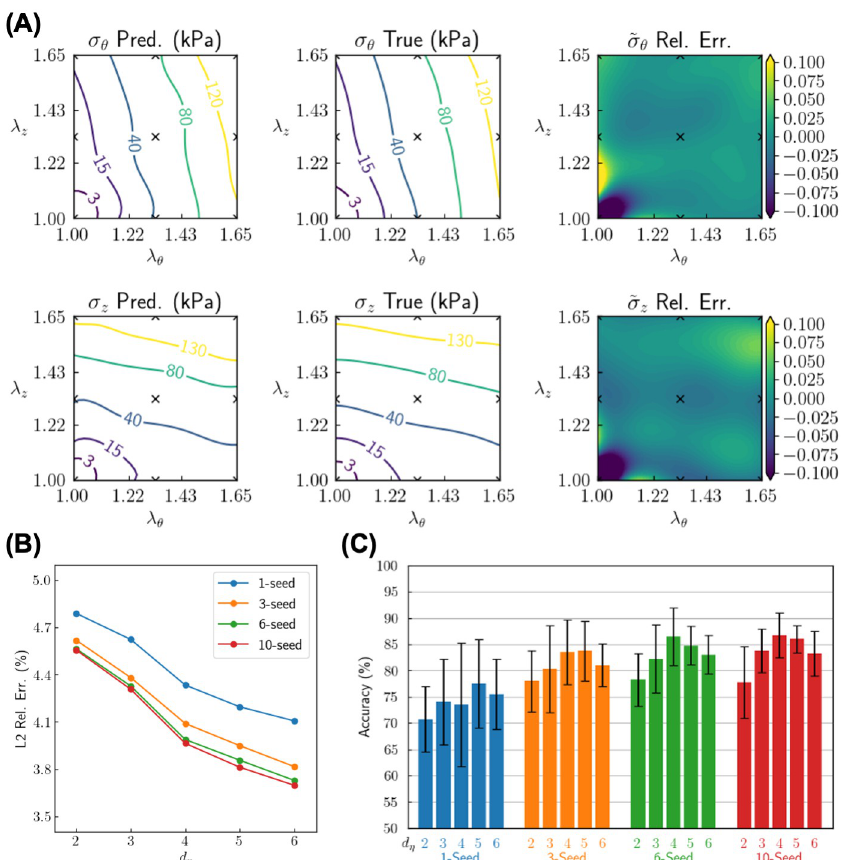
Fig 5. Reconstruction and classification results of sample inference based on structured data. Stress data are provided on 3 × 3 uniform grid points on the stretch plane. (A) Reconstruction of the stress-stretch relationship ( σ z and σ θ as functions of λ z and λ θ ) for a typical test sample from a 10-seed ensemble model. The predicted and true values of the stress are displayed by their respective physical values ( σ i where i = z , θ ; in kPa), while their difference is displayed as a relative (Rel.) error for normalized stress ~ s . (B) L 2 relative error of the predicted normalized stress ~ s i i with different sizes of ensemble (1-, 3-, 6- and 10-seed) and different dimensions of sample feature ( d η 2 {2, 3, 4, 5, 6}). Each dot is an average value over 20 runs with different choices of random seeds. (C) Classification accuracy for different sizes of ensemble and different dimensions of sample feature. Each bar is the average value over 20 runs with different choices of random